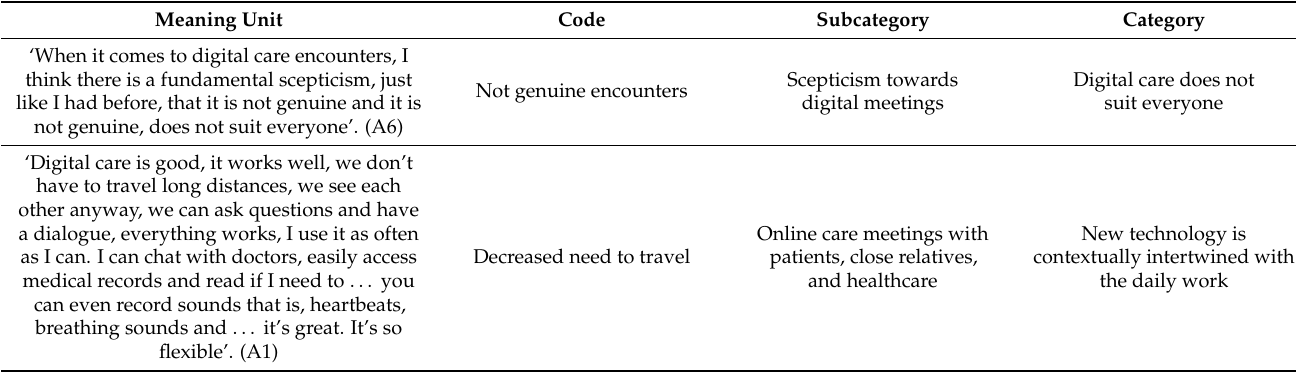
Table 1. Example of analysis process in inductive